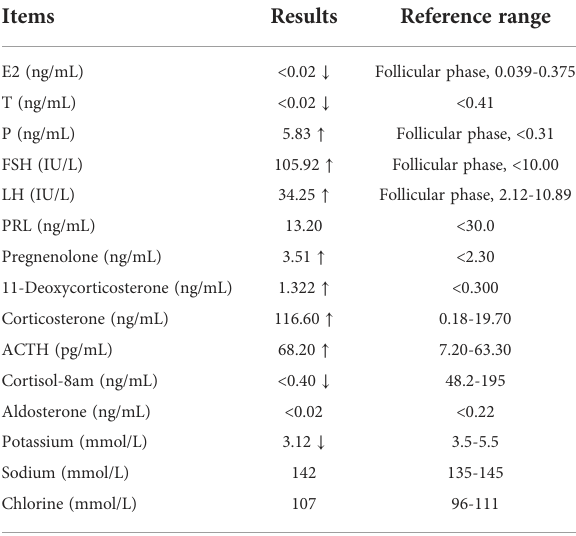
TABLE 1 Hormone levels and biochemical parameters of the patient.